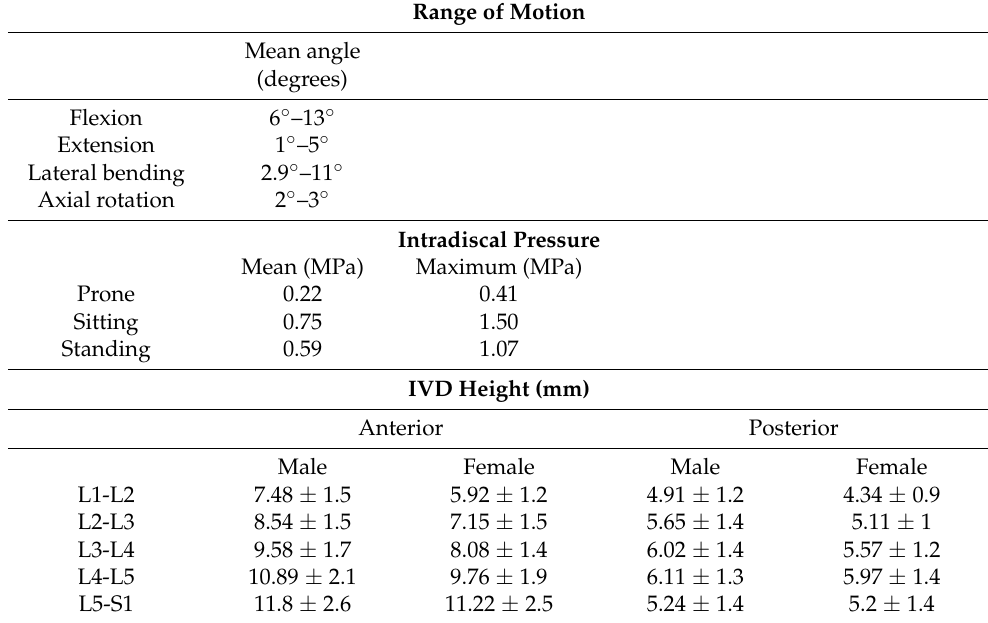
Table 2. Reference values for ROM, IDP, and IVD height in normal asymptomatic patients, data taken from